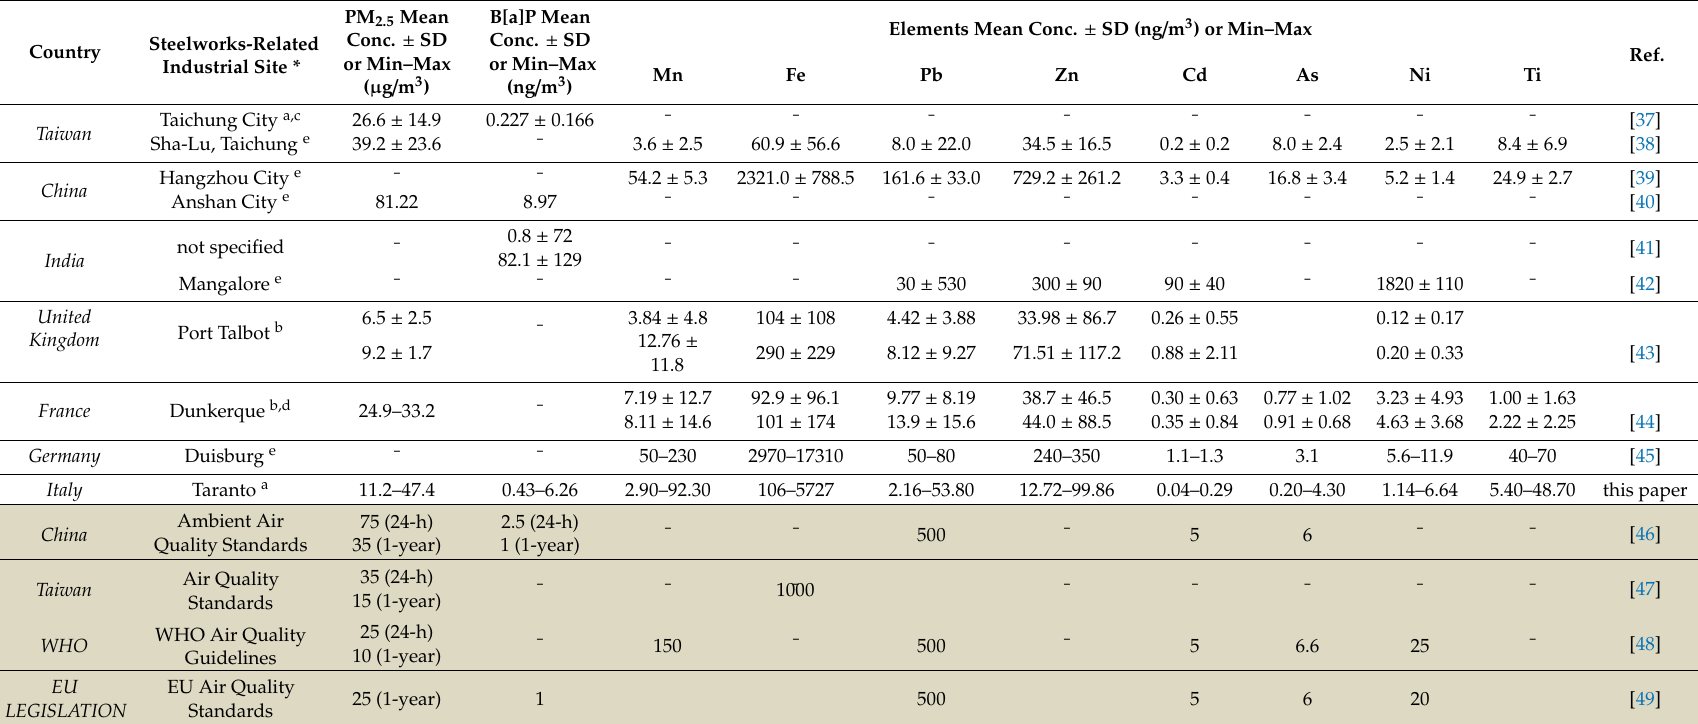
Table 5. PAHs and elements airborne concentrations nearby steelworks-related industrial sites